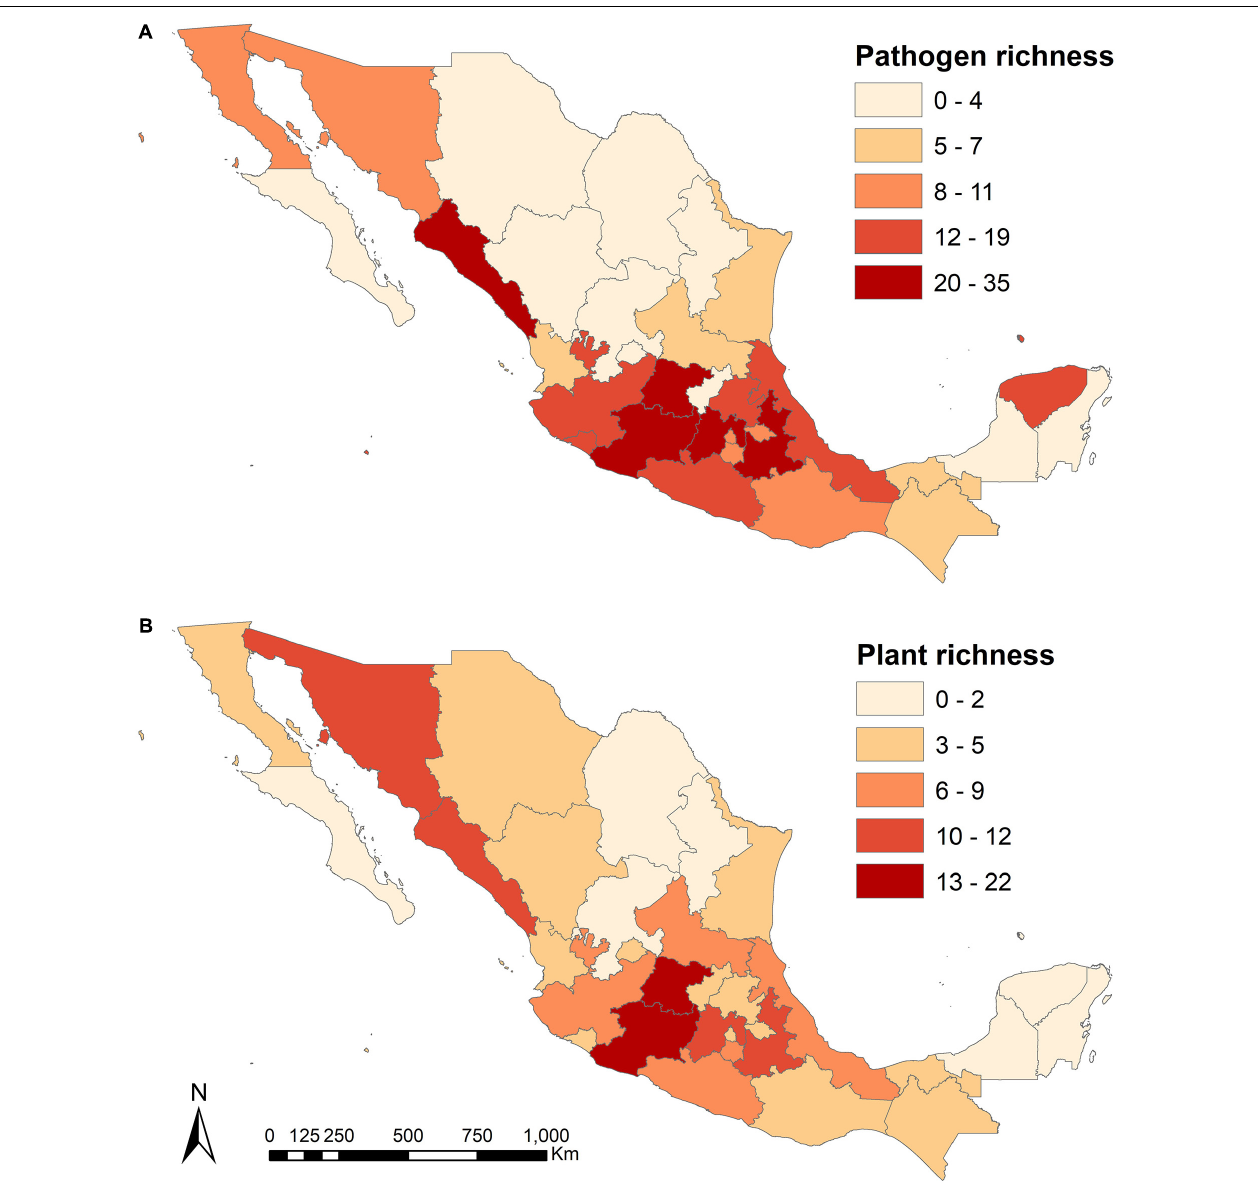
FIGURE 1 | The spatial distribution and richness of (A) fusaria pathogenic species; and (B) host-plant species present throughout mainland Mexico (see Table 1 and Supplementary Material